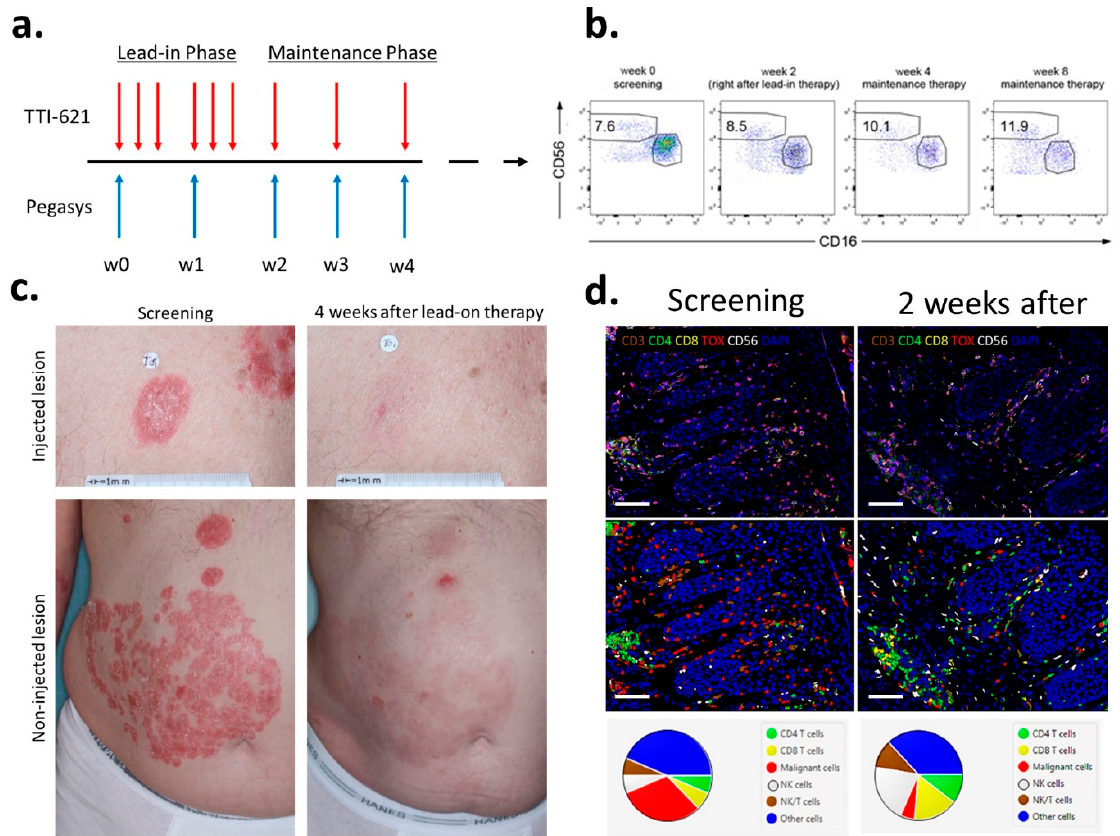
Figure 6. Interferon- α supplementation primes clinical response to CD47 blockade. ( a ) Schematic of the clinical trial design. ( b ) An increase of NK cells (CD3-CD16-CD56 bright ) in the peripheral blood of a representative patient treated with a com- bination of TTI-621 and pegylated IFN- α 2a. Cells gated on CD3 − . ( c ) Clinical images of a patient with relapsed/refractory tumor MF treated with six intra-tumoral injections of TTI-621 combined with two subcutaneous injections of PEG-IFN- α 2a. The patient discontinued the treatment after the lead-in phase. The response is 4 weeks after stopping all the medi- cations. ( d ) Multispectral fluorescent immunohistochemistry of skin biopsies before and 2 weeks after the Lead-In Phase (top panels, scale bar 100 μ m). Cell segmentation with phenotype map (bottom panels, scale bar 100 μ m) shows as influx of NK cells in TME after treatment and a decrease in the percentage of tumor cells.